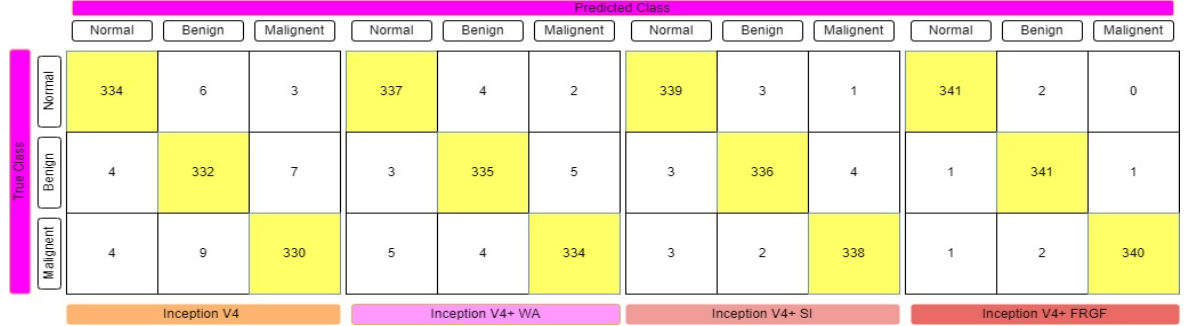
97.08%, and 97.67% accuracy, respectively.